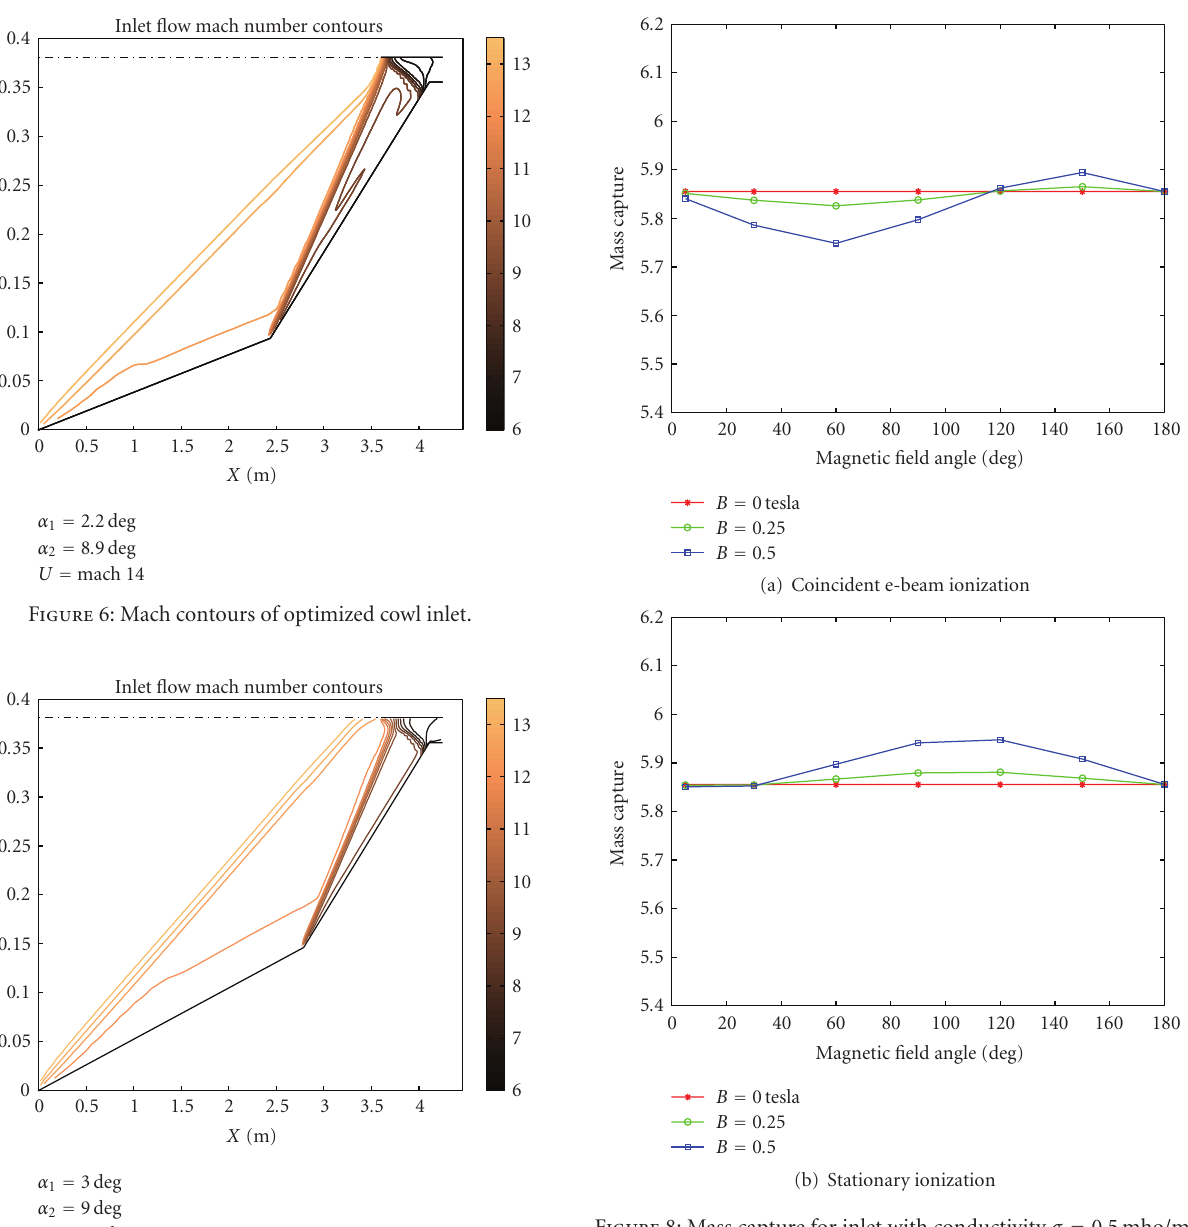
Figure 8: Mass capture for inlet with conductivity σ = 0 . 5 mho/m. Results are shown for (a) coincident ionization and (b) stationary